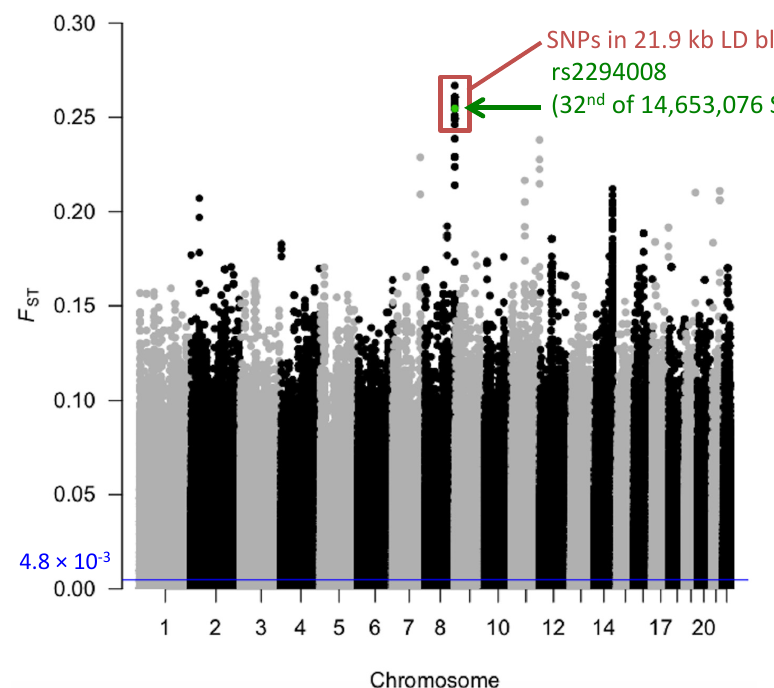
Figure 1. Manhattan plot of F ST values between JPT and CHB. Each dot represents an F ST value of each autosomal SNP. Green dot represents the F ST value at rs2294008 and red box indicates SNPs in the LD block (21.9 kb) containing rs2294008. The average F ST (4.8 × 10 − 3 ) is represented by the blue horizontal line.